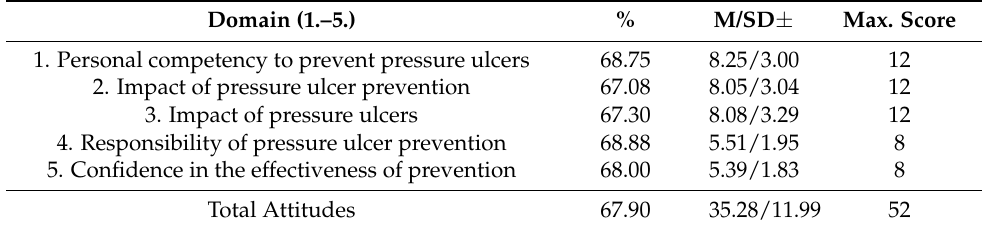
Table 2. Descriptive statistics of Attitudes (domains and total).